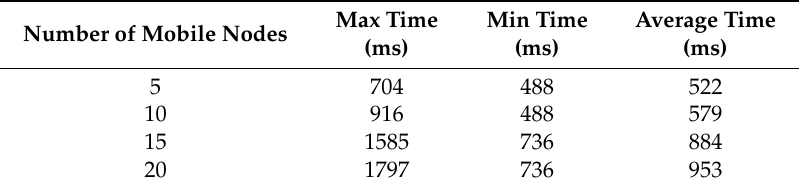
Table 2. Time of mobile nodes